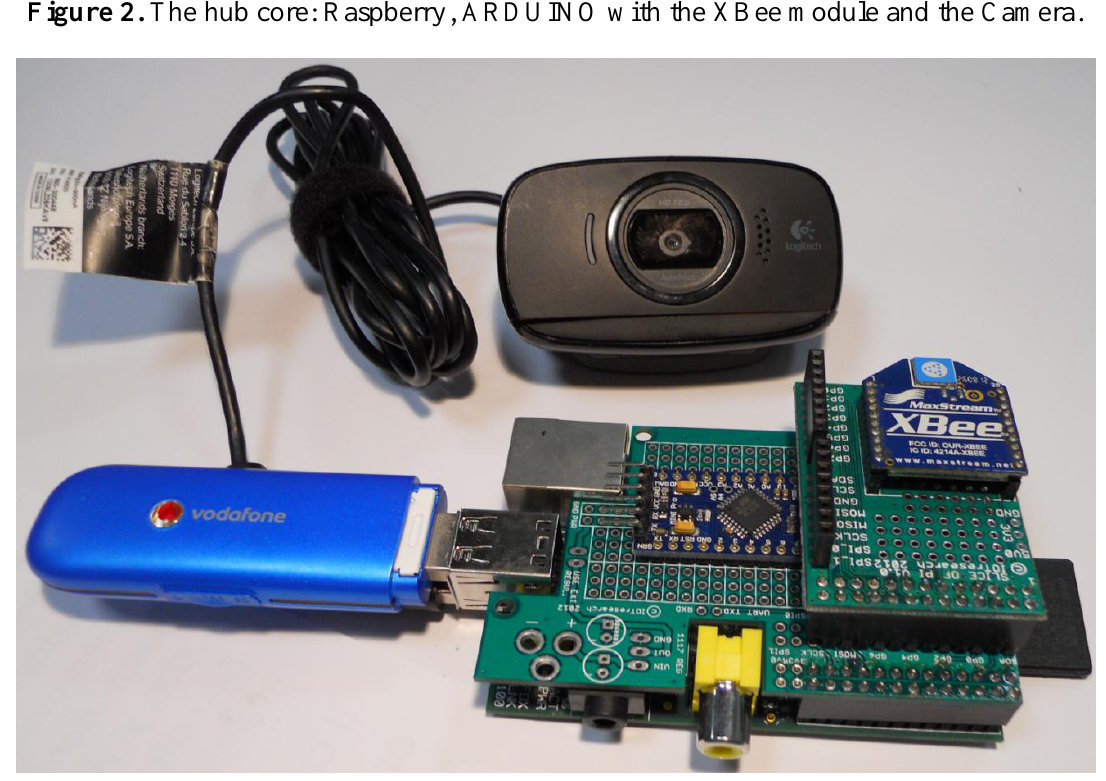
Connected to the hub there is also a high resolution camera directly driven by the